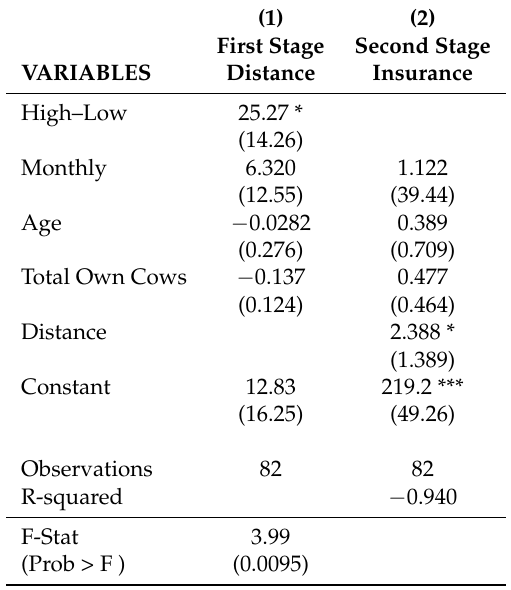
Table A2. First and Second Stage of Table 8, IVREG, and the Effects of Distance on the Amount of Insurance Purchased in Groups.